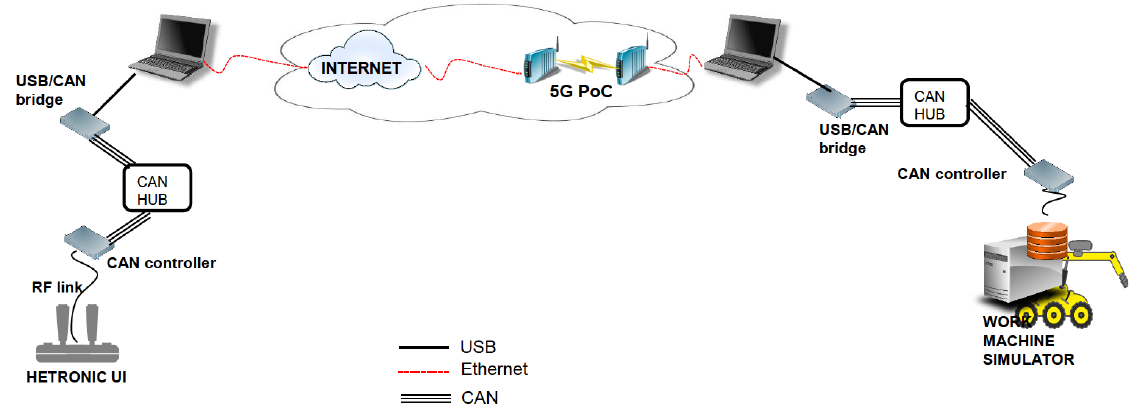
Figure 4: System architecture for the open loop remote control of a virtual machine with a hardware-in-the-loop controller.